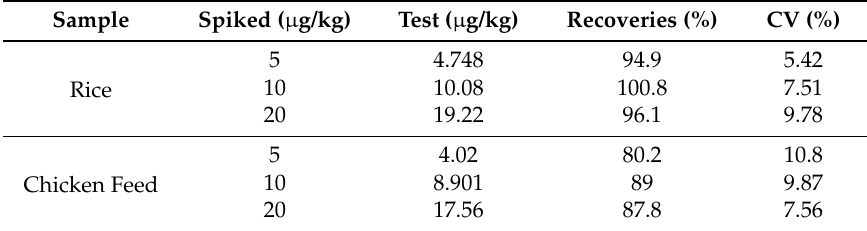
Table 2. Recoveries and CV values for T-2 in rice and chicken